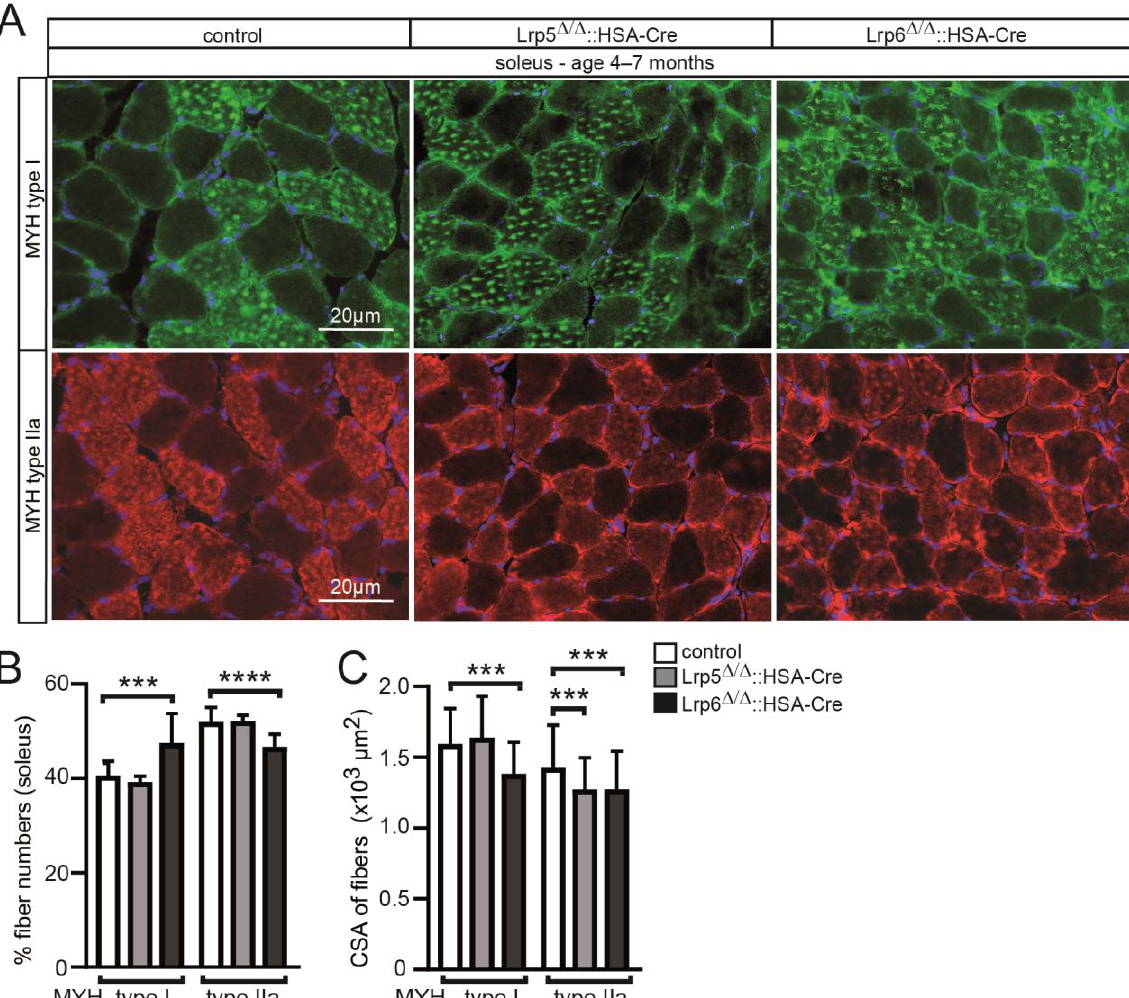
Figure 3. Muscle fiber type distribution and size are changed in conditional Lrp5 or Lrp6 knockout mice. ( A ) Soleus muscle of adult control and conditional Lrp5 or Lrp6 knockout mice were cross- sectioned and immunostained with myosin heavy chain antibodies. Representative images are shown. ( B ) Number of fibers of type I and IIa was counted and is presented by a graph. Note that conditional Lrp6 knockout muscles are composed of slightly more type I and less type IIa fibers. ( C ) Cross-sectional areas of type I and type IIa muscle fibers of control and Lrp5 or Lrp6 conditional knockout mice are summarized. Note that cross-sectional areas are differently reduced in Lrp5 or Lrp6 mutant mice in comparison with controls. All labeling of graph bars represents genotype of mice as indicated in ( C ). **** p < 0.0001, *** p < 0.001.